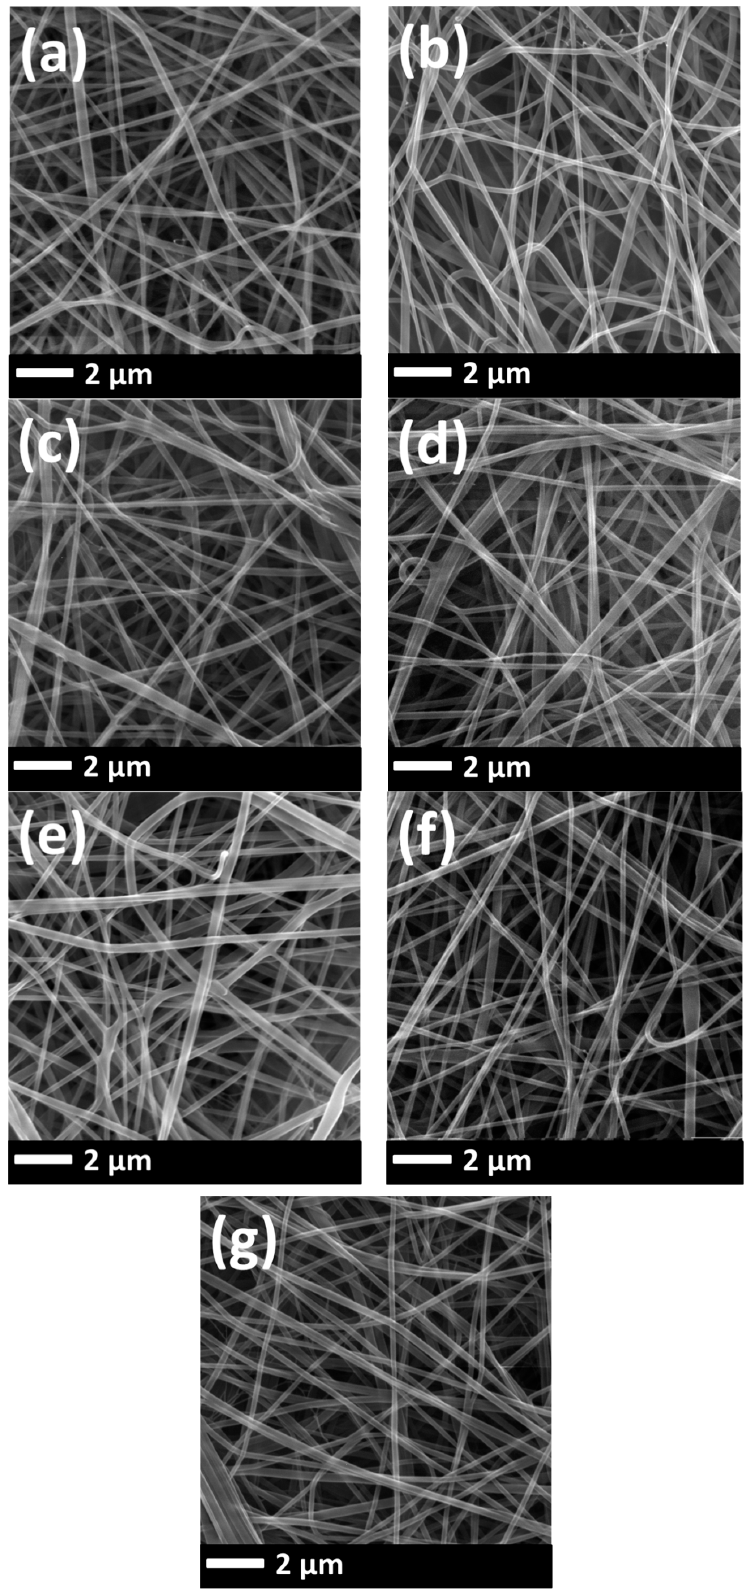
Figure A1. SEM images of ( a ) PVDF_110_2_50, ( b ) PVDF_110_5_40, ( c ) PVDF_110_5_50, ( d ) PVDF_120_3_40, ( e ) PVDF_125_3_50, ( f ) PVDF_130_2_40, ( g ) PVDF_130_3_50 after lamination process.